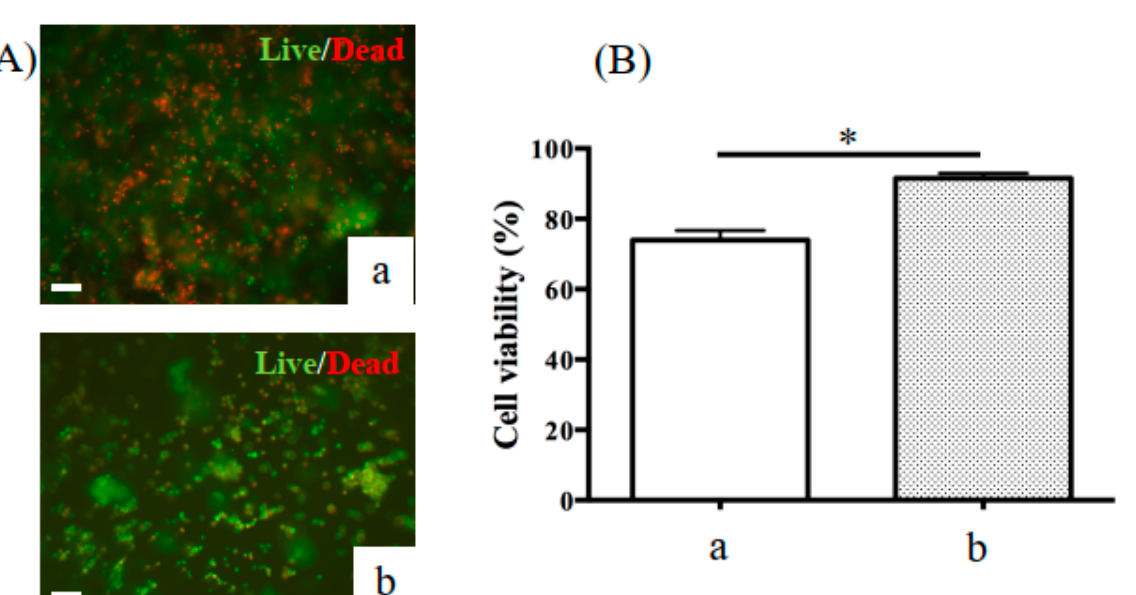
Figure 3. Representative fluorescence images of KUSA-A1 cells stained green (live) and red (dead). ( A ) The viability of cells encapsulated in 20% GelMA hydrogels after exposure to ( a ) UV light or ( b ) VW light and cultured in vitro for 1 day was measured. ( B ) Cell viability decreased when KUSA-A1 cells were exposed to ( a ) UV light as opposed to ( b ) VW light; * p < 0.05. UV: ultraviolet. Scale bars: 100 μ m.